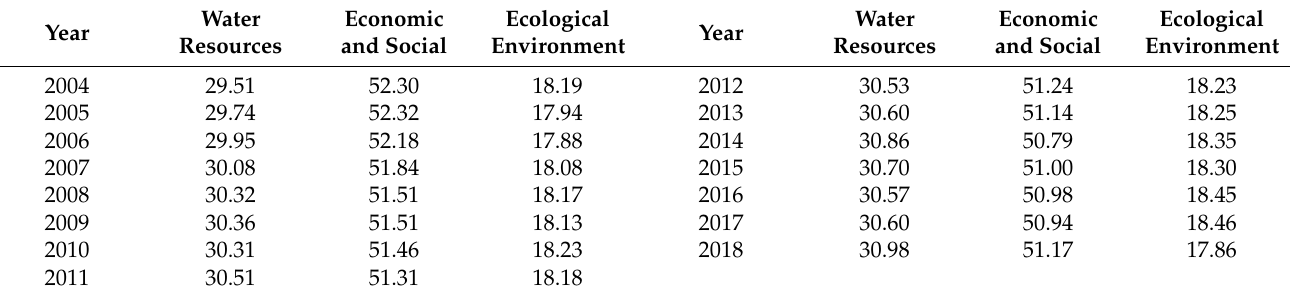
Table 4. Subsystem level barriers to AUCWR in 2004–2018 (%).